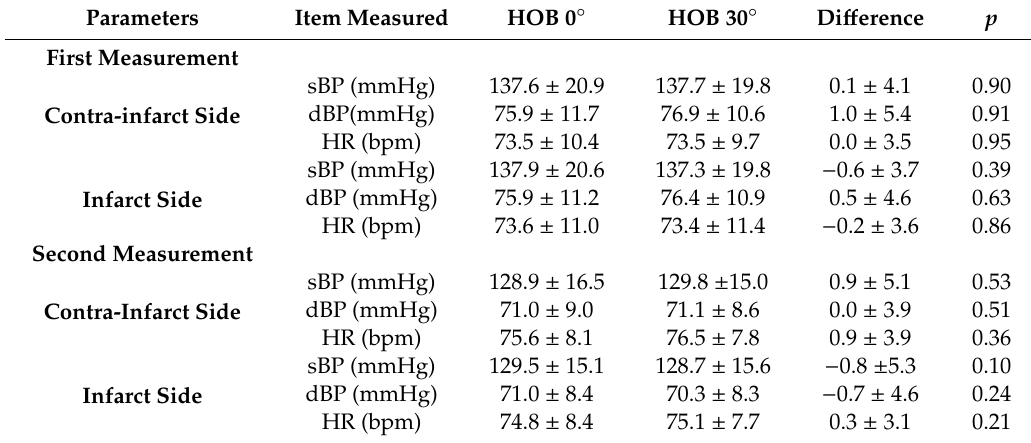
Table 2. Comparisons of the systemic blood pressure and heart rate in response to HOB manipulation. Parameters Item Measured HOB 0 ◦ HOB 30 ◦ Di ff erence First Measurement Contra-infarct Side